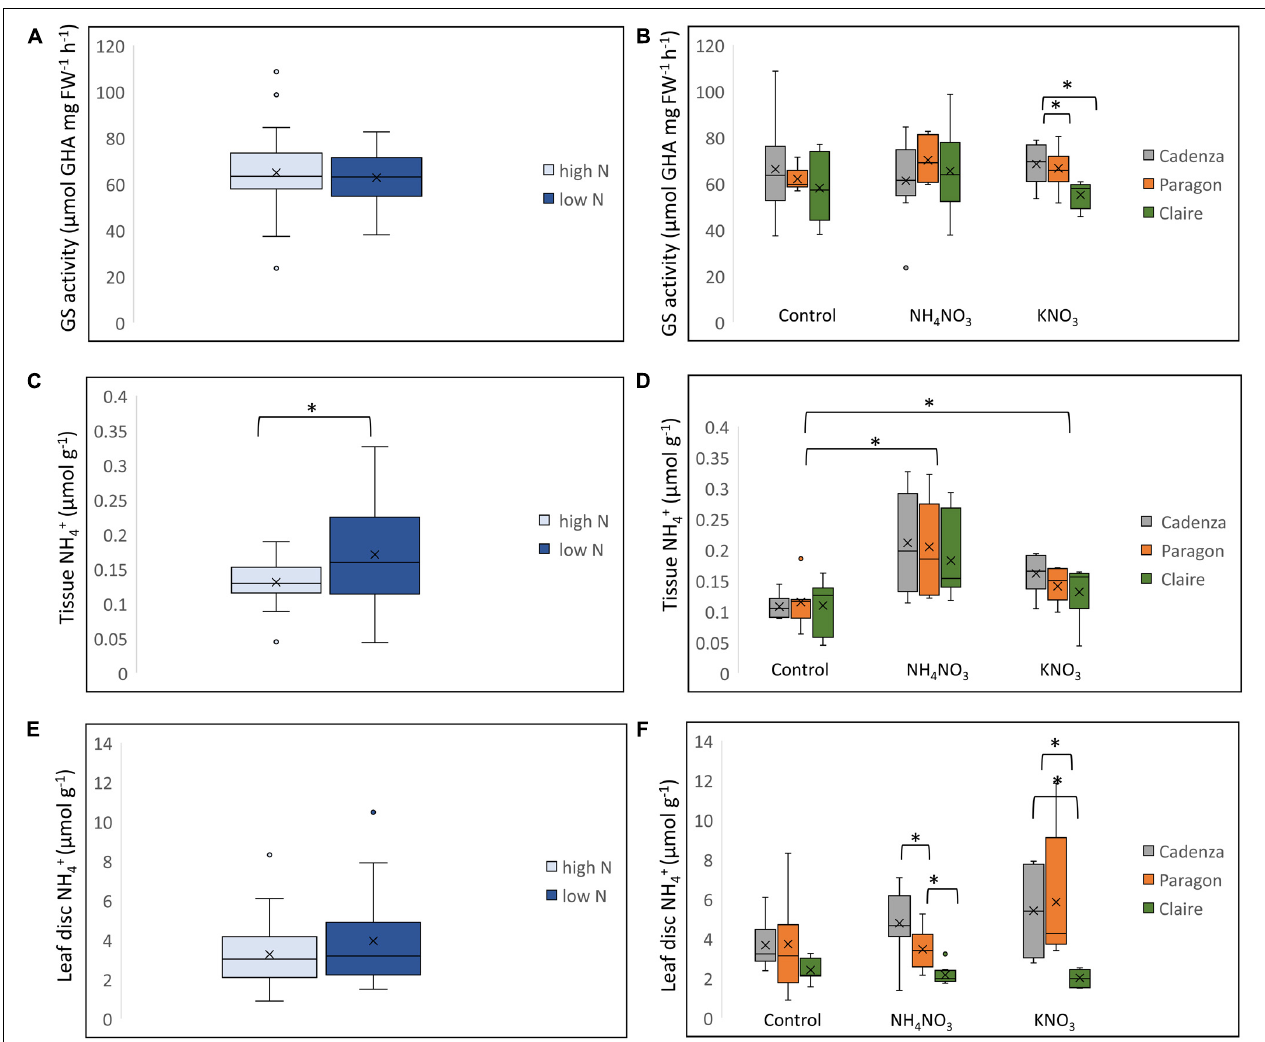
FIGURE 6 | Differential N response in plants grown under high and low N conditions. Selected genotypes, Cadenza, Paragon and Claire, were grown under low-N and high-N conditions until the 3–4 tiller stage and then treated with the equivalent of 250 kg N ha − 1 as NH 4 NO 3 and KNO 3 , respectively. Water was used for control plants. GS activity (A) , leaf tissue NH 4 + (C) and leaf-disc NH 4 + (E) were measured and compared between low-N and high-N plants. The effect of different treatments on GS enzyme activity (B) , leaf tissue NH 4 + (D) and leaf-disc NH 4 + (F) was compared between the three genotypes. Asterisks indicate significant differences between means ( p < 0.05) of each